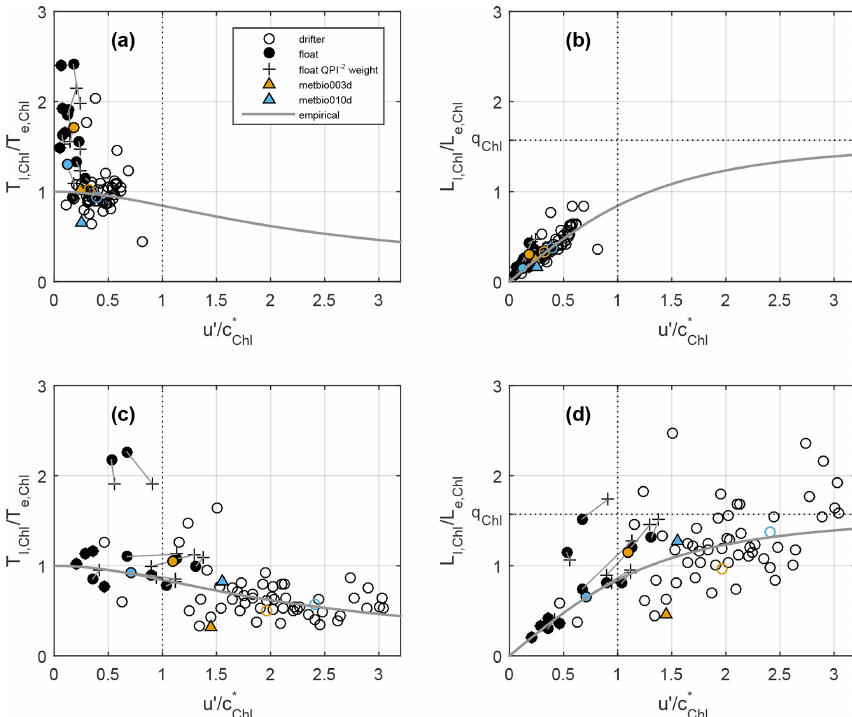
Figure 6. Scatter plots of chlorophyll time and length scales for Lagrangian ( T l , Chl and L l , Chl ) and Eulerian ( T e , Chl and L e , Chl ) frames: (a) T l , Chl /T e , Chl as a function of u (cid:48) /c ∗ from anomalies relative to the smoothed subtrahend, where u (cid:48) is a scale for the mesoscale eddy Chl = L velocities, and c ∗ is the evolution speed for the chlorophyll field ( c ∗ e , Chl /T e , Chl ); (b) L l , Chl /L e , Chl as a function of u Chl Chl anomalies relative to the smoothed subtrahend. Panels (c) and (d) are the same as panels (a) and (b) but for anomalies relative to the climatology subtrahend. Symbols are identified in the legend and are exactly the same as in Fig. 5. Grey curves are from Eq. (12), with q Chl = π/ 2 and s = 2.